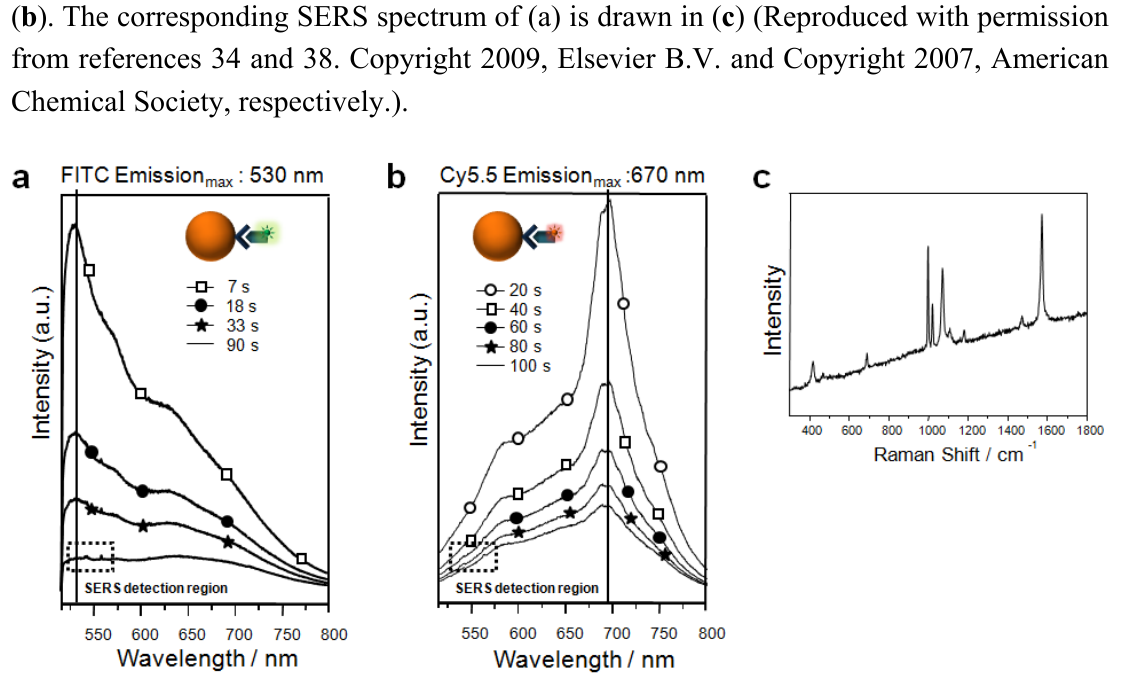
Figure 7. Fluorescence change after photoexcitation by a 514.5-nm laser line on SERS beads incubated with streptavidin-FITC conjugate ( a ) and with streptavidin-Cy5